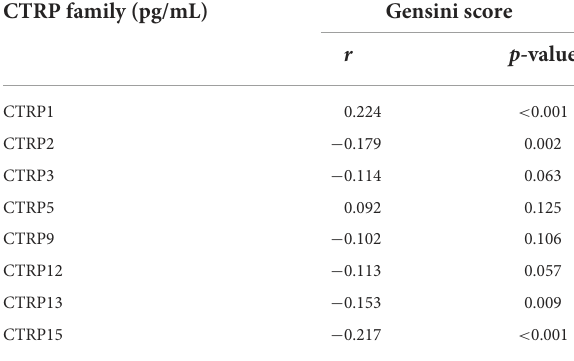
a decreasing trend across the quartiles of Gensini score ( p < 0.05, TABLE 4 Correlation analysis of CTRP family and Gensini